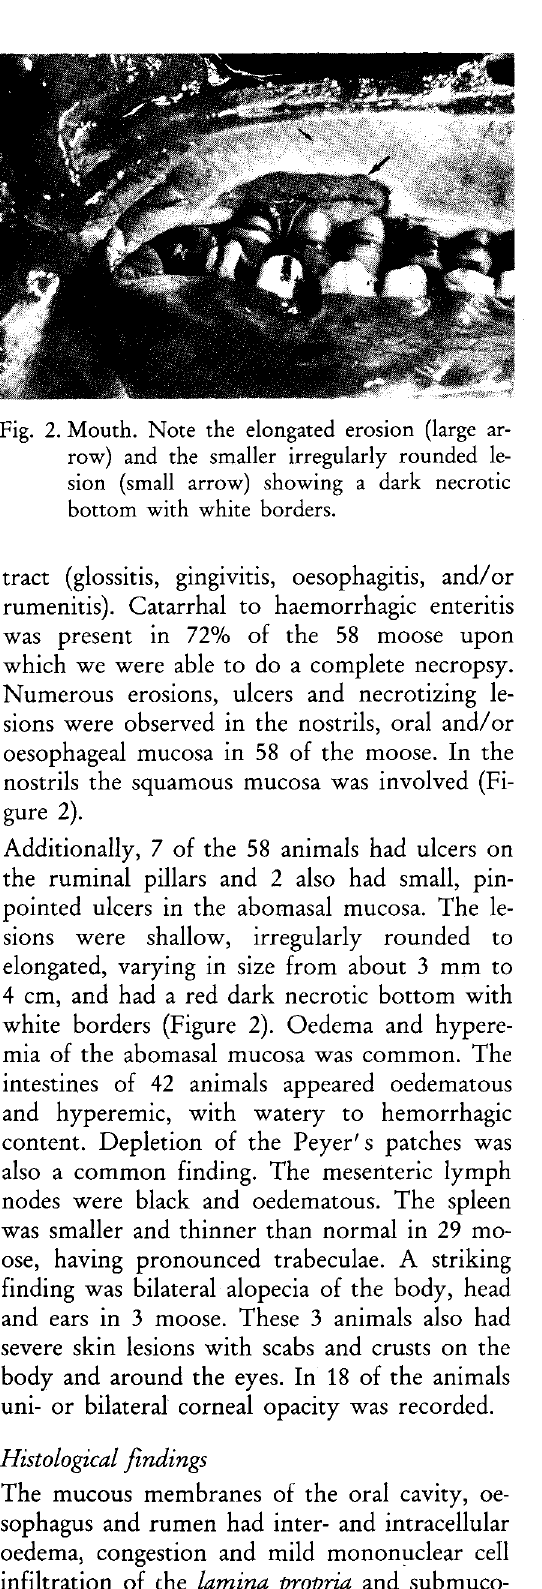
Fig. 2. Mouth. Note the elongated erosion (large ar row) and the smaller irregularly rounded le sion (small arrow) showing a dark necrotic bottom with white borders.